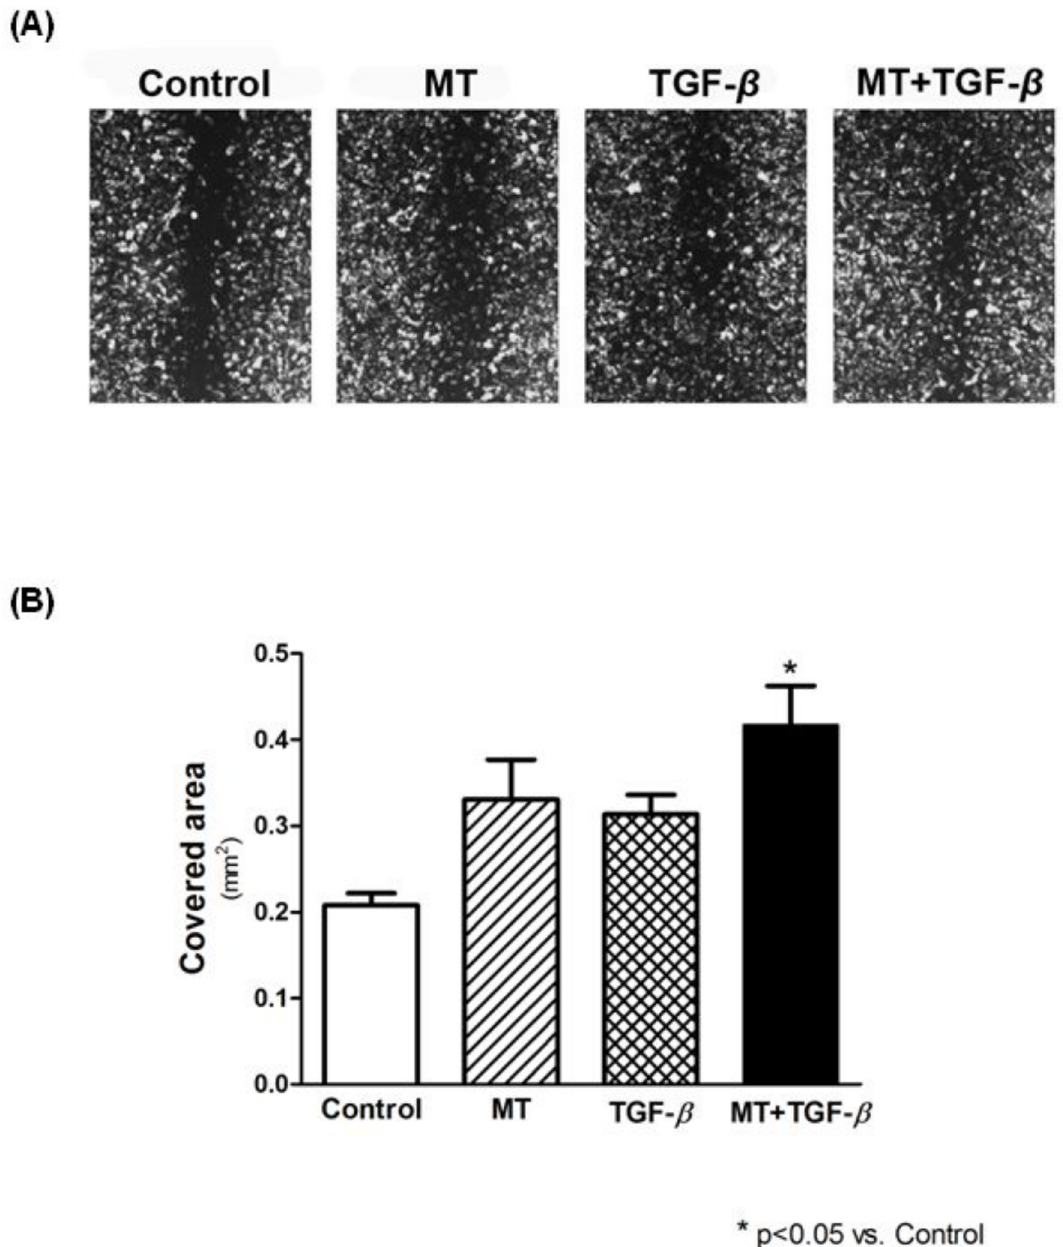
Fig 6. The scratch-wound assay was used to assess migration of T24 cells under MT and TGF- β 1 stimulus. (A) Images were captured at 40X magnification under an inverted microscope, three hours after scratch formation. (B) Wound closure was significantly faster in MT + TGF- β compared to